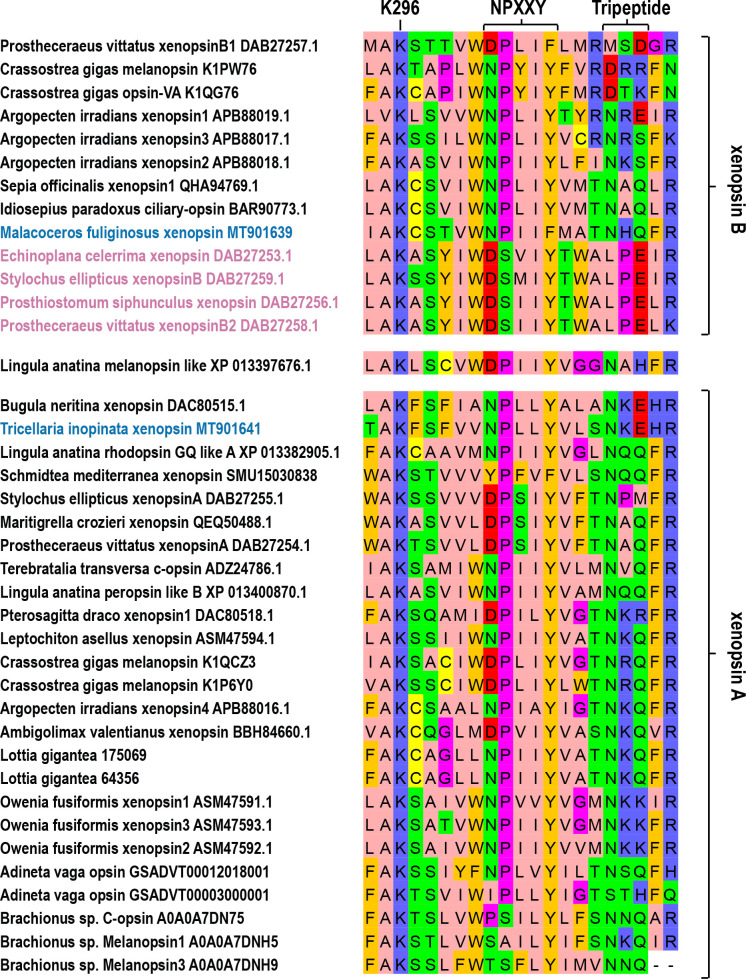
Conservation of functionally important motifs and residues in xenopsins.Alignment of parts of the transmembrane domain VII and the cytosolic helix VIII of selected opsin sequences showing the conserved lysine 296 (K296) chromophore binding site and other motifs important for opsin-G protein interaction like NPXXY and the tripeptide. The tripeptide and the NPXXY motif are strongly modified in several flatworm xenopsin B sequences (highlighted in red), but are conserved in M. fuliginosus and T. inopinata xenopsin (highlighted in blue).